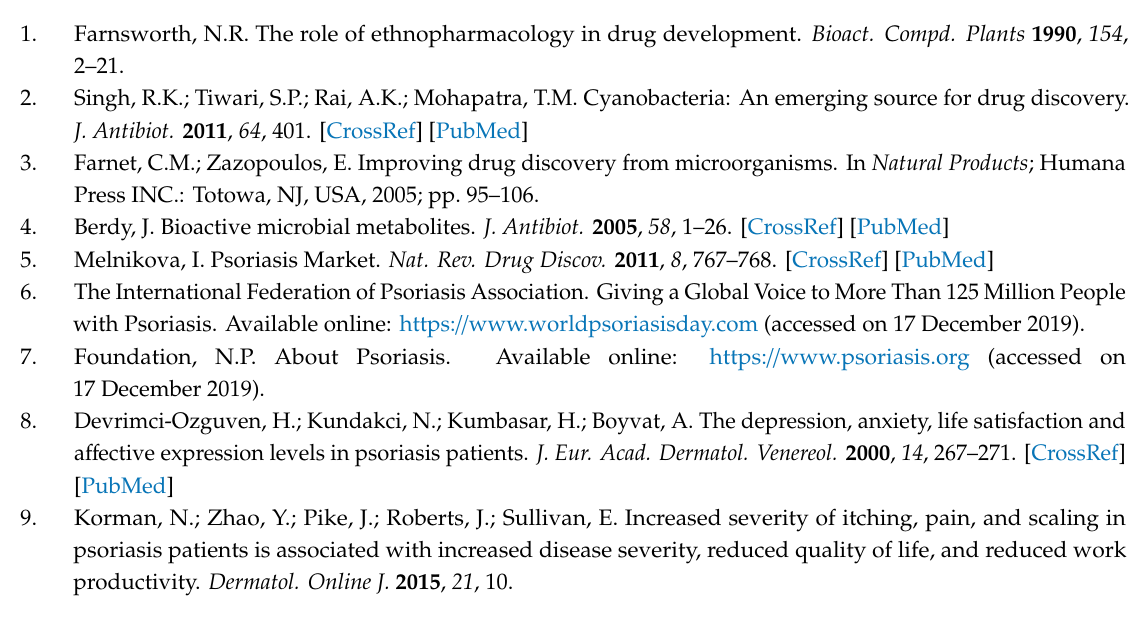
Figure S1: Nitric oxide (NO) production by RAW 264.7 cells in the presence of cyanobacteria ethanol extracts, without stimulation with lipopolysascharide (LPS). Figure S2: Nitric oxide (NO) production by RAW 264.7 cells in the presence of cyanobacteria acetone extracts, without stimulation with lipopolysascharide (LPS). Figure S3: RAW 264.7 cells viability after 24 h of incubation with cyanobacteria ethanol and acetone extracts. Figure S4: Keratinocytes (HaCaT) viability after 24 h and 48 h of incubation with cyanobacteria ethanol extracts. Figure S5: Keratinocytes (HaCaT) viability after 24 h and 48 h of incubation with cyanobacteria acetone